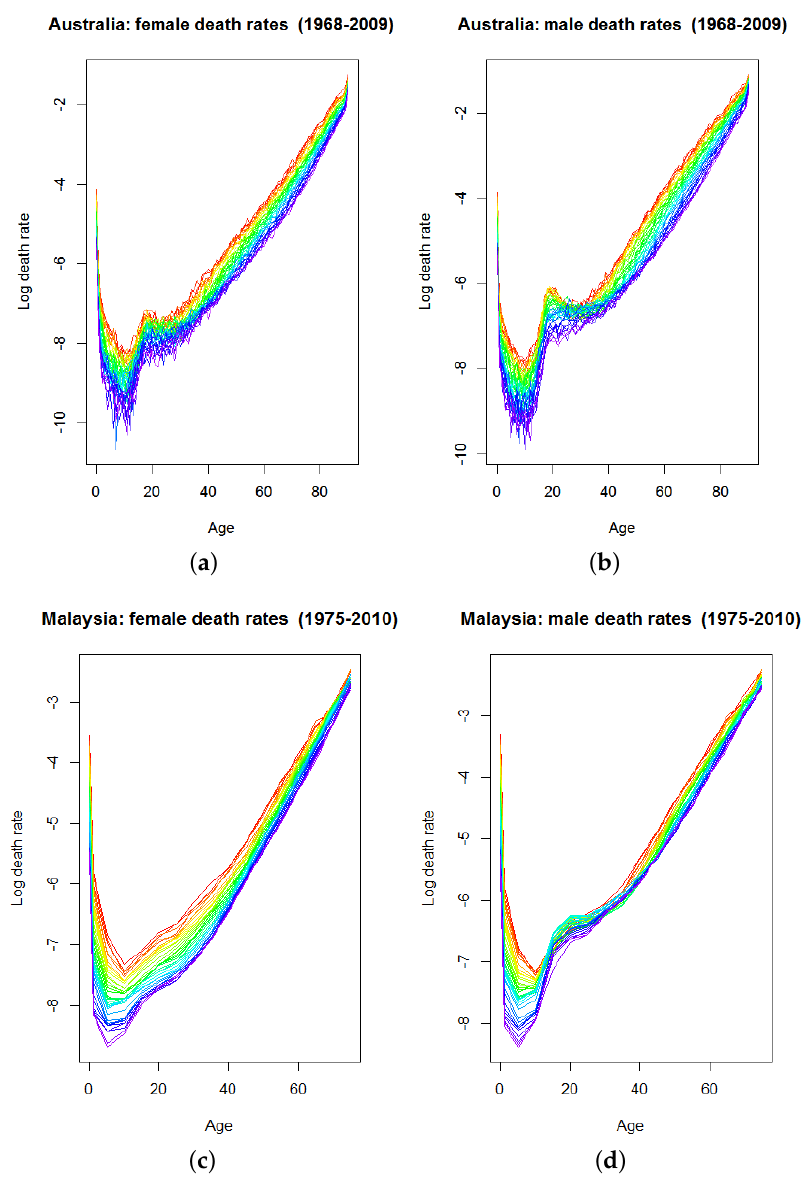
Figure 2. The rainbow age-specific log death rate plots for ( a ) Australian females, ( b ) Australian males, ( c ) Malaysian females and ( d ) Malaysian